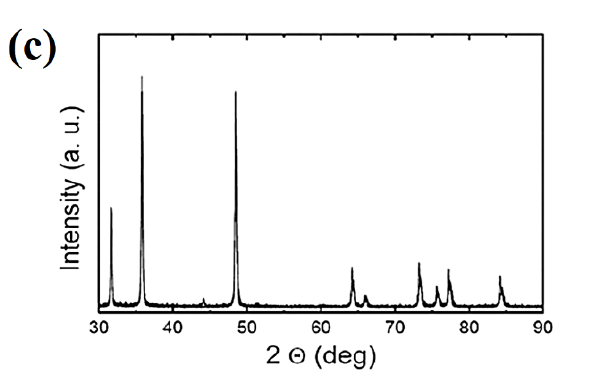
Figure 1. Characterization of titanium diboride (TiB 2 ) NPs. ( a ) scanning electron microscope (SEM) analysis of TiB 2 NPs, ( b ) transmission electron microscope (TEM) analysis of TiB 2 NPs and ( c ) X-ray crystallography (XRD) analysis of TiB 2 NPs.